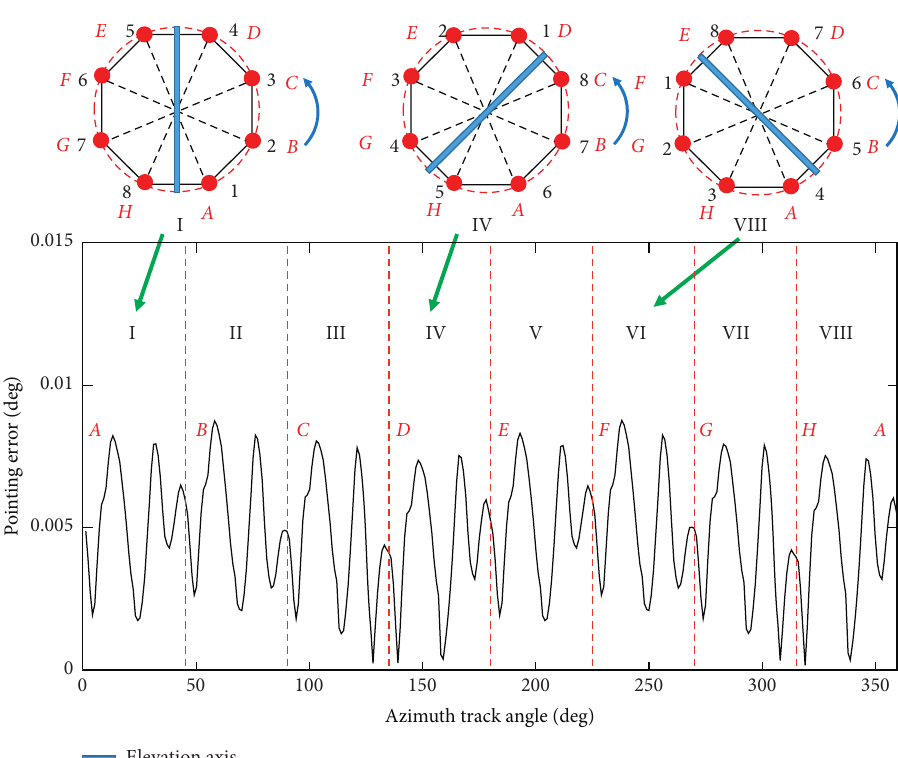
Figure 13: Telescope pointing error for the eight-support-point case (Elevation angle is set to be 1